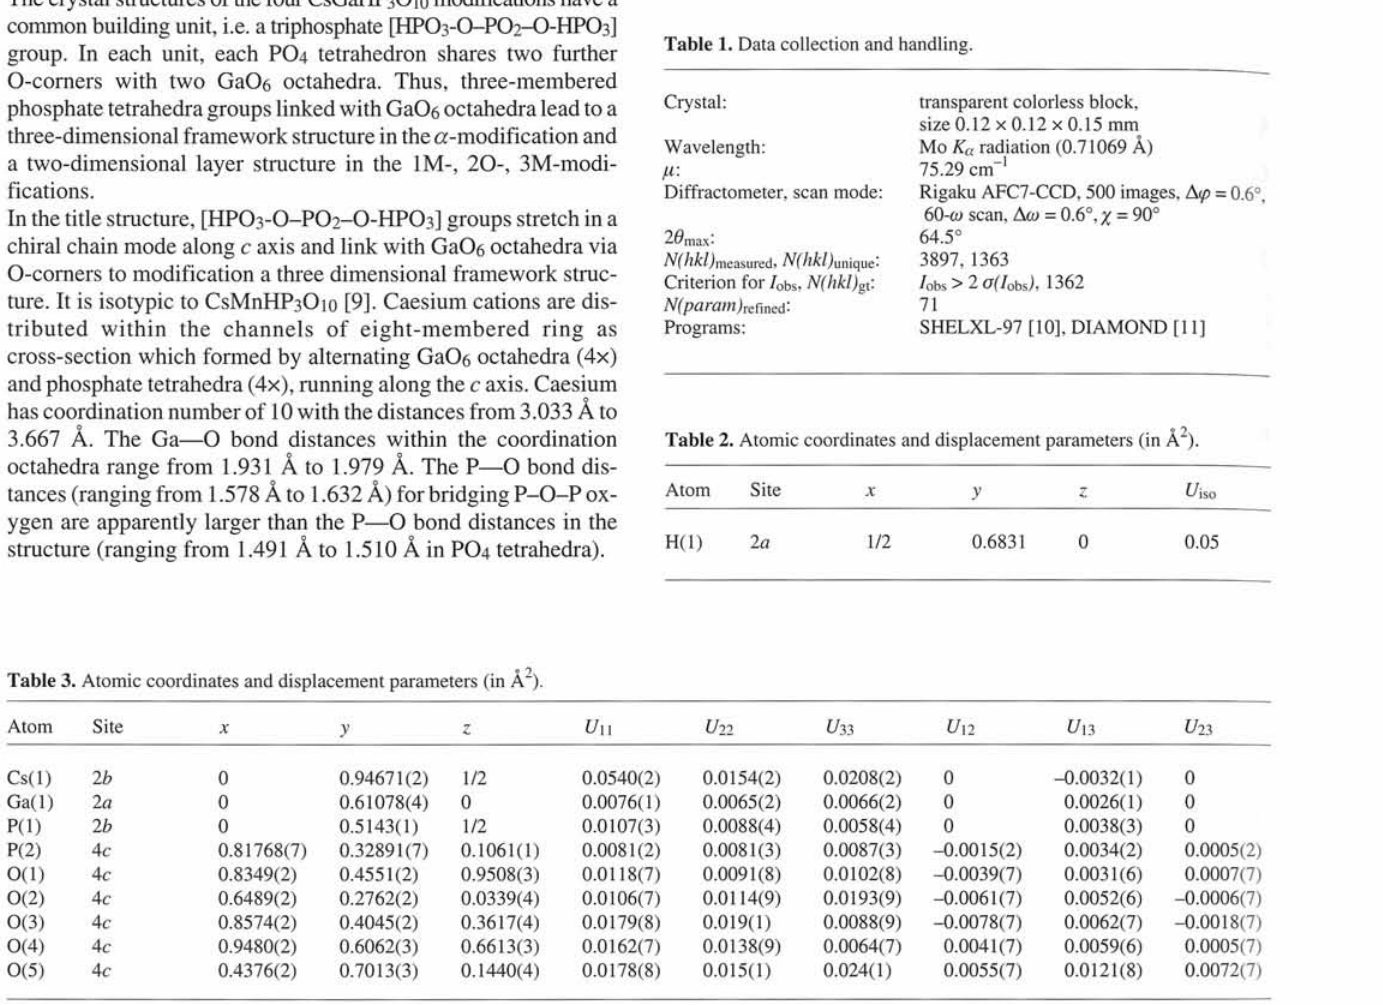
Table 1. Data collection and handling.